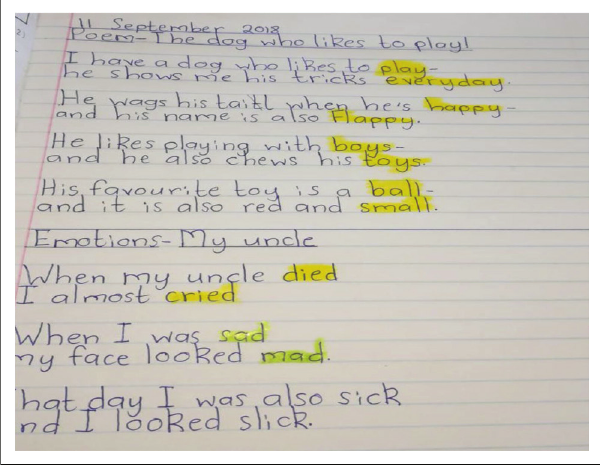
FIGURE 4: Emotion and